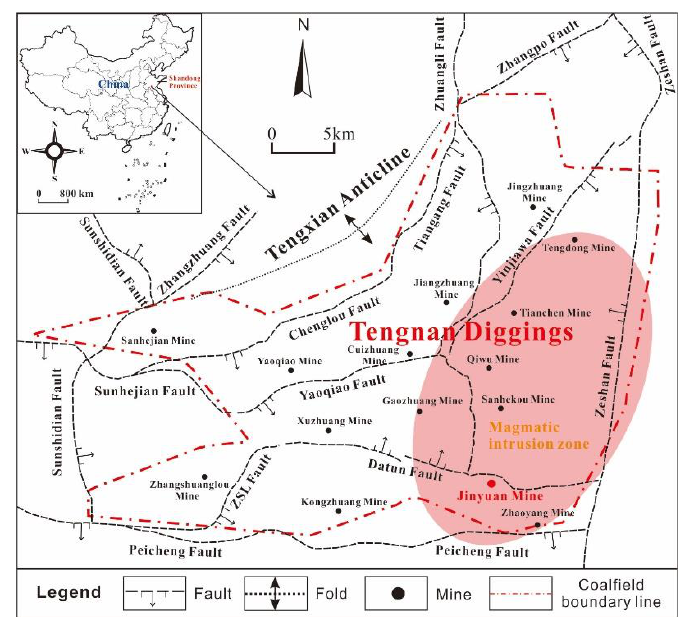
Figure 1. The geotectonic position of the Tengnan Diggings, as well as locations of coal mines and a geological map of Tengnan Diggings. Minerals 2020 , 10 , x FOR PEER REVIEW